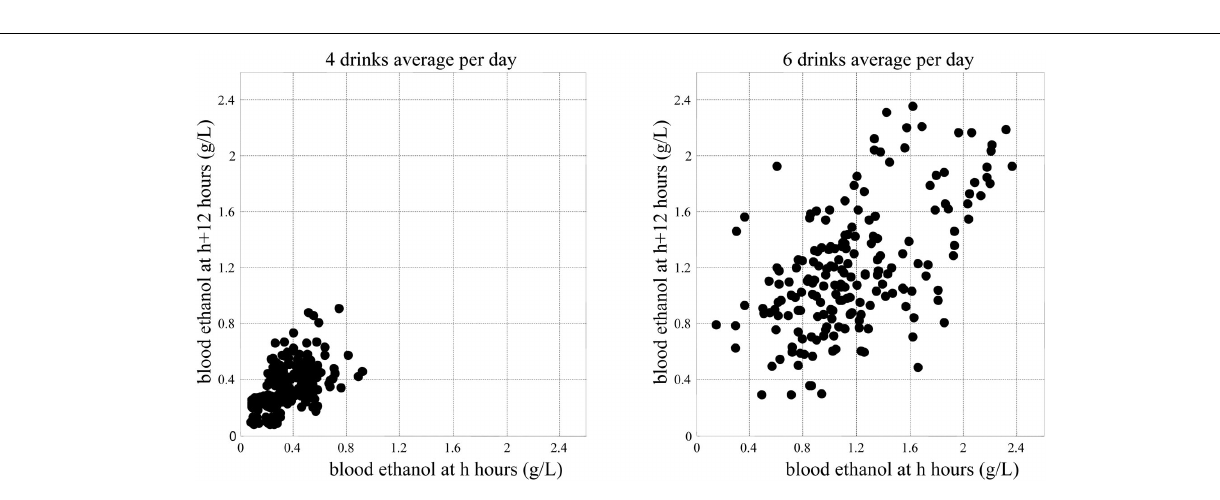
FIGURE 11 | System phase transition from stable to unstable dynamics indicated by Poincaré plots of the system